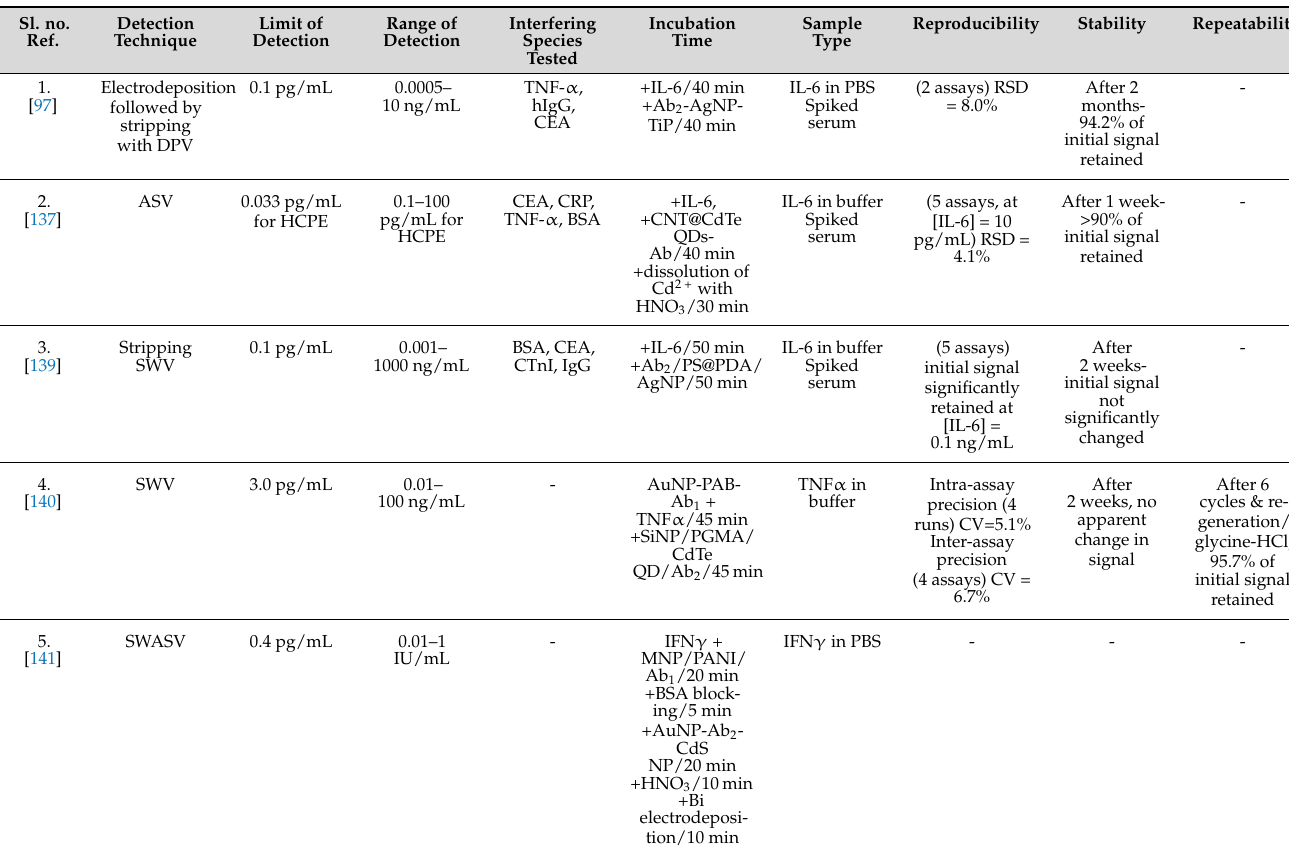
Table 8. Heavy metal nanoparticle-labeled immunosensors: Specifications and performance characteristics. Sl. no.